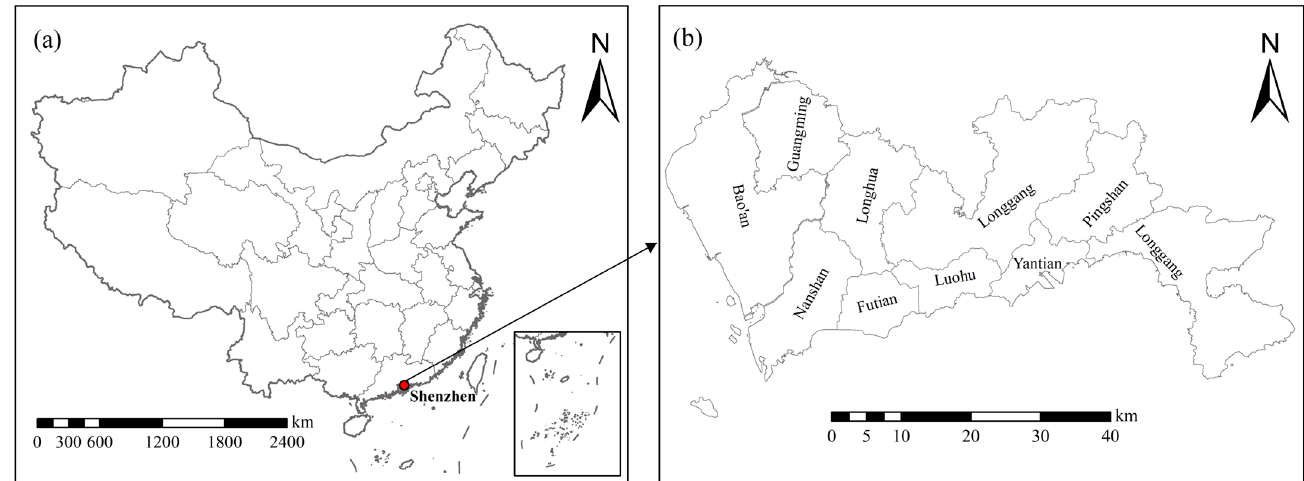
Figure 2. ( a ) Location of Shenzhen in China; ( b ) the administrative districts in Shenzhen.